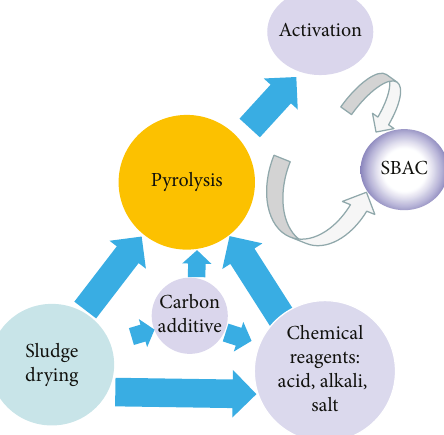
Figure 1: The mode for preparation of